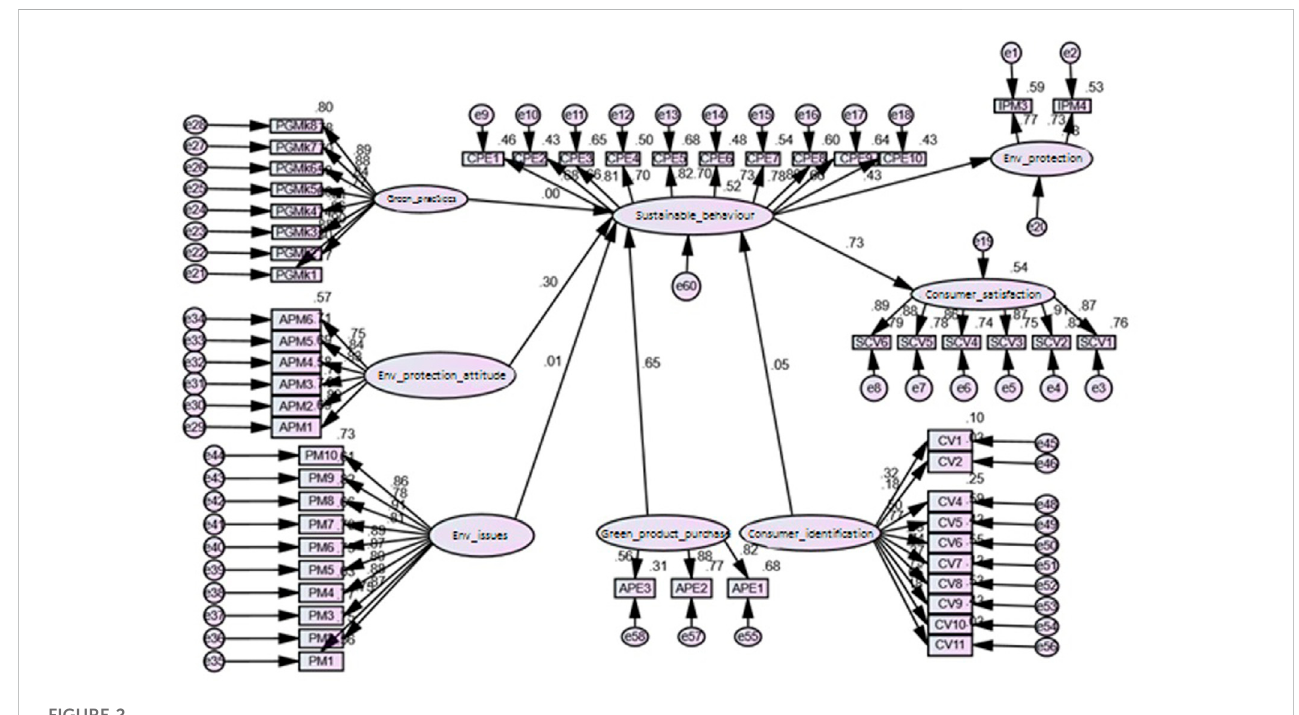
FIGURE 2 Structural